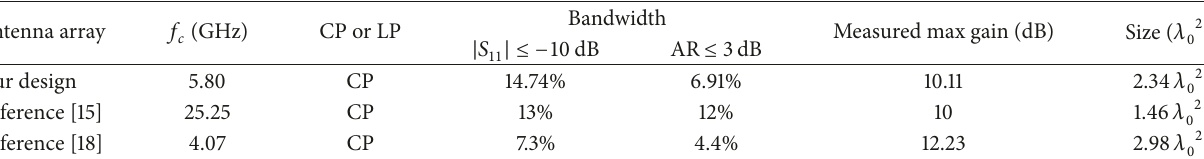
Table 4: A comparison of the proposed array with other similar arrays.